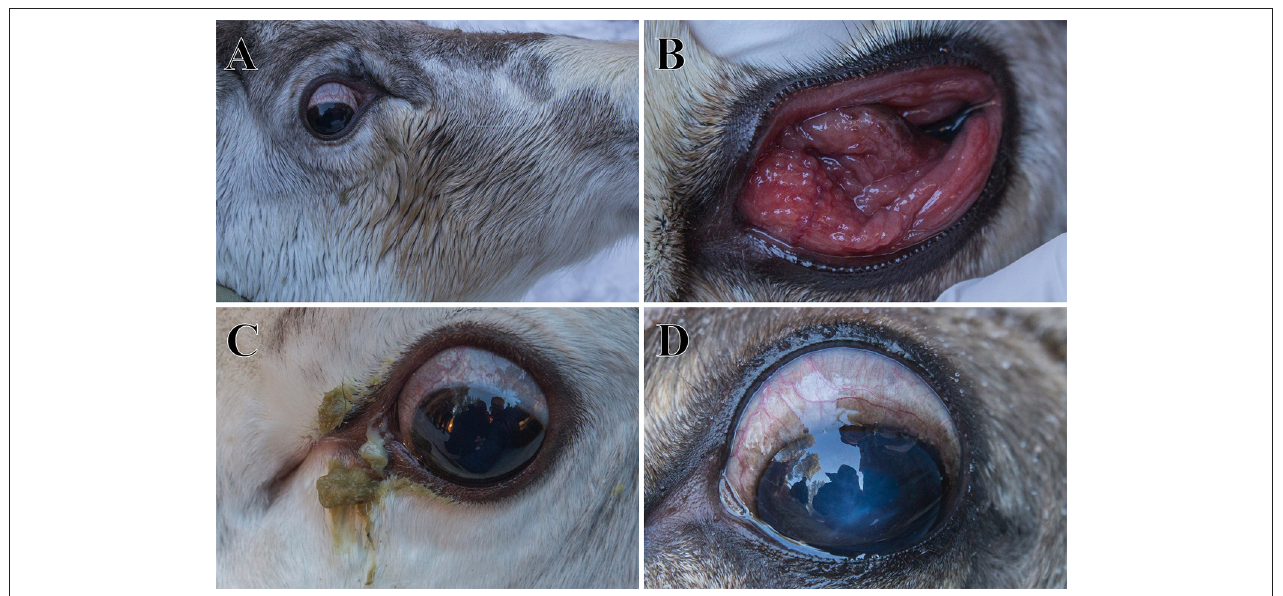
FIGURE 1 | Clinical signs of infectious keratoconjunctivitis in semi-domesticated Eurasian tundra reindeer ( Rangifer t. tarandus ) observed during the clinical evaluation and sampling of animals in March 2017 in Östra Kikkejaure, Sweden. Animals displayed unilateral or bilateral increased lacrimation and ocular discharge shown as discoloration of the fur (A) , follicular conjunctivitis (B) , purulent secretions from the affected eyes (C) , and/or corneal edema, visible as an opaque cornea with a bluish coloration (D) .